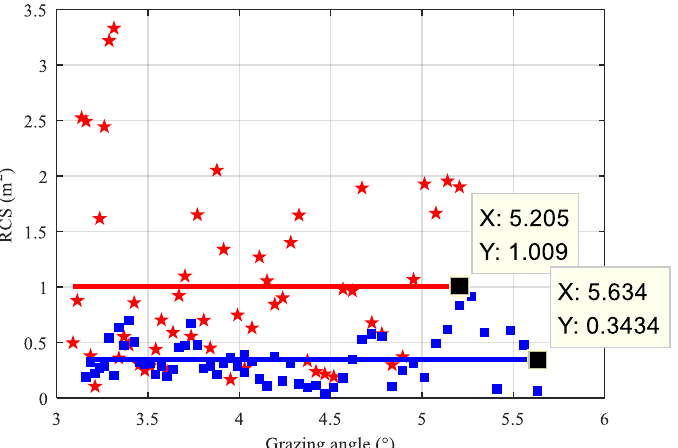
Figure 7. Average RCS comparison of data #201 with data #202 at a grazing angle of about 3.0 ◦ to 5.6 ◦ , where the red star is the average RCS in each range bin for data #201, the red line is the RCS mean value for #201, the blue square is the average RCS in each range bin for data #202, and the blue line is the RCS mean value for #202. Table 4. Target RCS characteristic parameters.